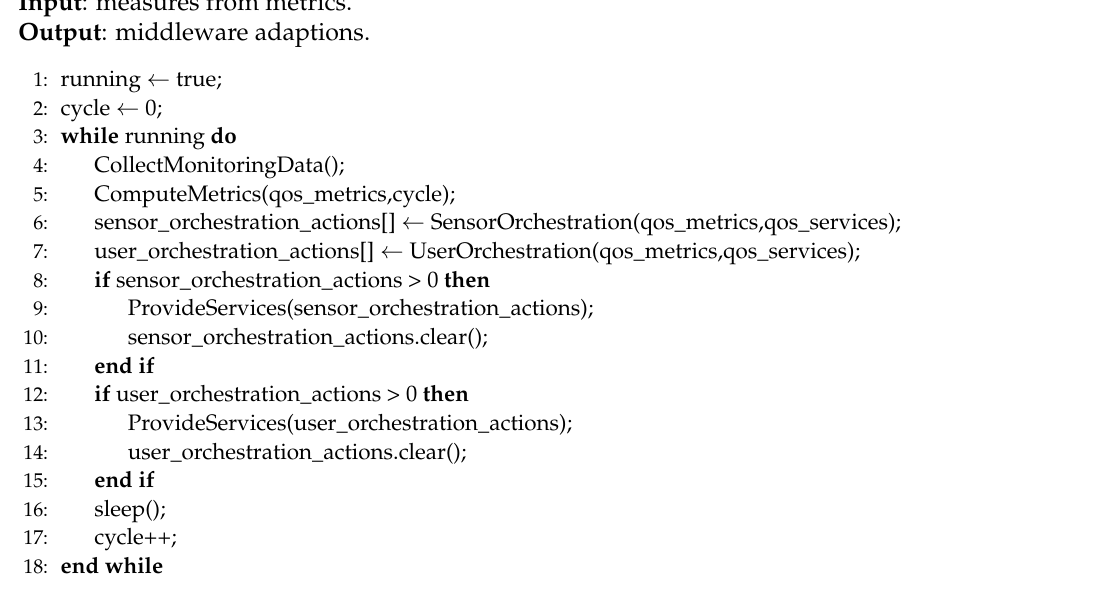
Algorithm 1 QualiCare Manager Main Tasks.